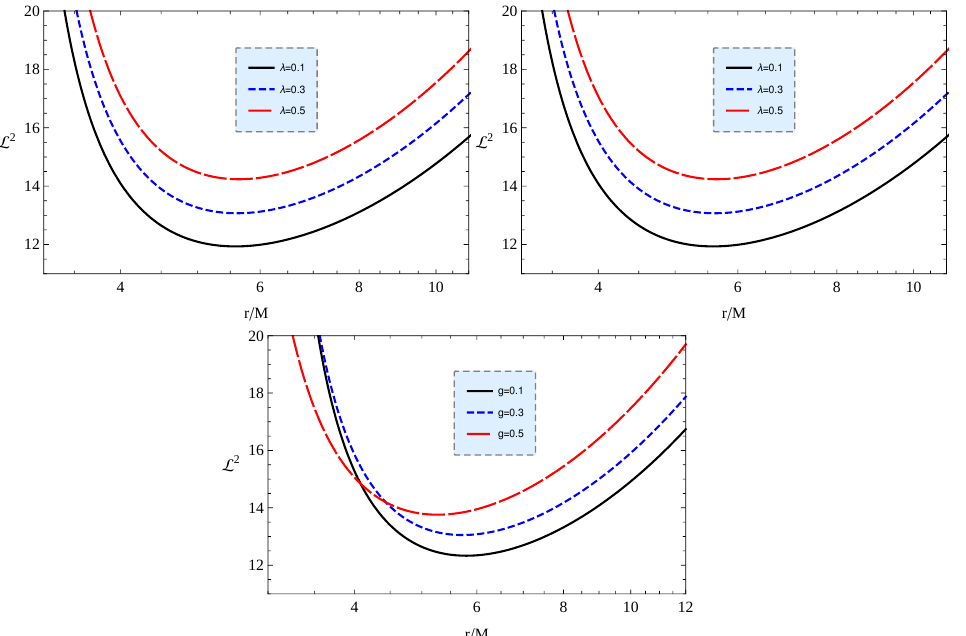
Figure 9. Angular momentum square dependence on radial distance for magnetically charged test particles, moving around the Bardeen regular black hole in 4D EGB gravity, possessing magnetic charge g . Top panels: L 2 against r / M for different values of magnetic charge parameter λ and for the parameter α in the case of fixed g = 0.5. Bottom panel: For different values of the parameter g in the case of fixed α = 0.3 and λ =